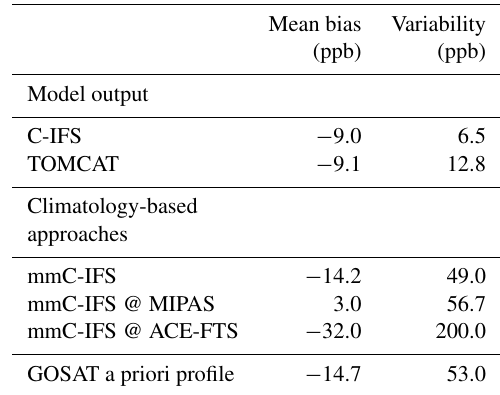
Figure 7. Maps showing the CH 4 concentration (in ppb) at the 10hPa pressure level for the months September to November 2010. Panel (a) shows the CH 4 concentration as measured by MIPAS. Panels (b) and (c) show the CH 4 concentrations modelled by C- IFS and TOMCAT, respectively, sampled at the location and times of the MIPAS measurements. Panels (c) and (d) show the bias be- tween the models and the MIPAS measurements.